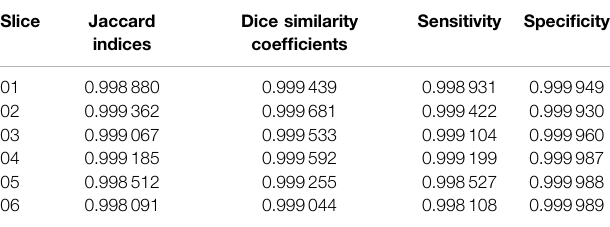
TABLE 1 | The performance of the minimum spanning tree approach based on data set number two, presented using Jaccard Indices, Dice Similarity Coef fi cients, Sensitivity, and Speci fi city.